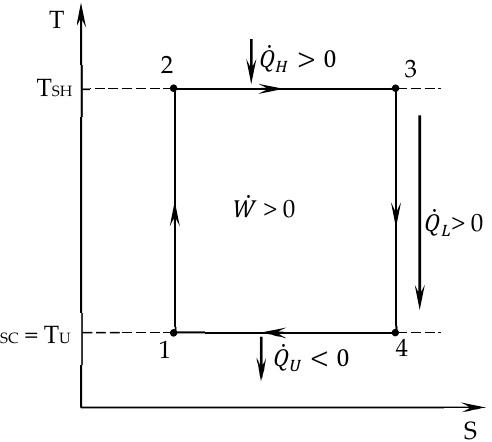
Figure 12. Non-adiabatic Carnot engine as the topping cycle of CHHP. With the steady state hypothesis (nominal regime for dimensioning purpose), the energy balance corresponds